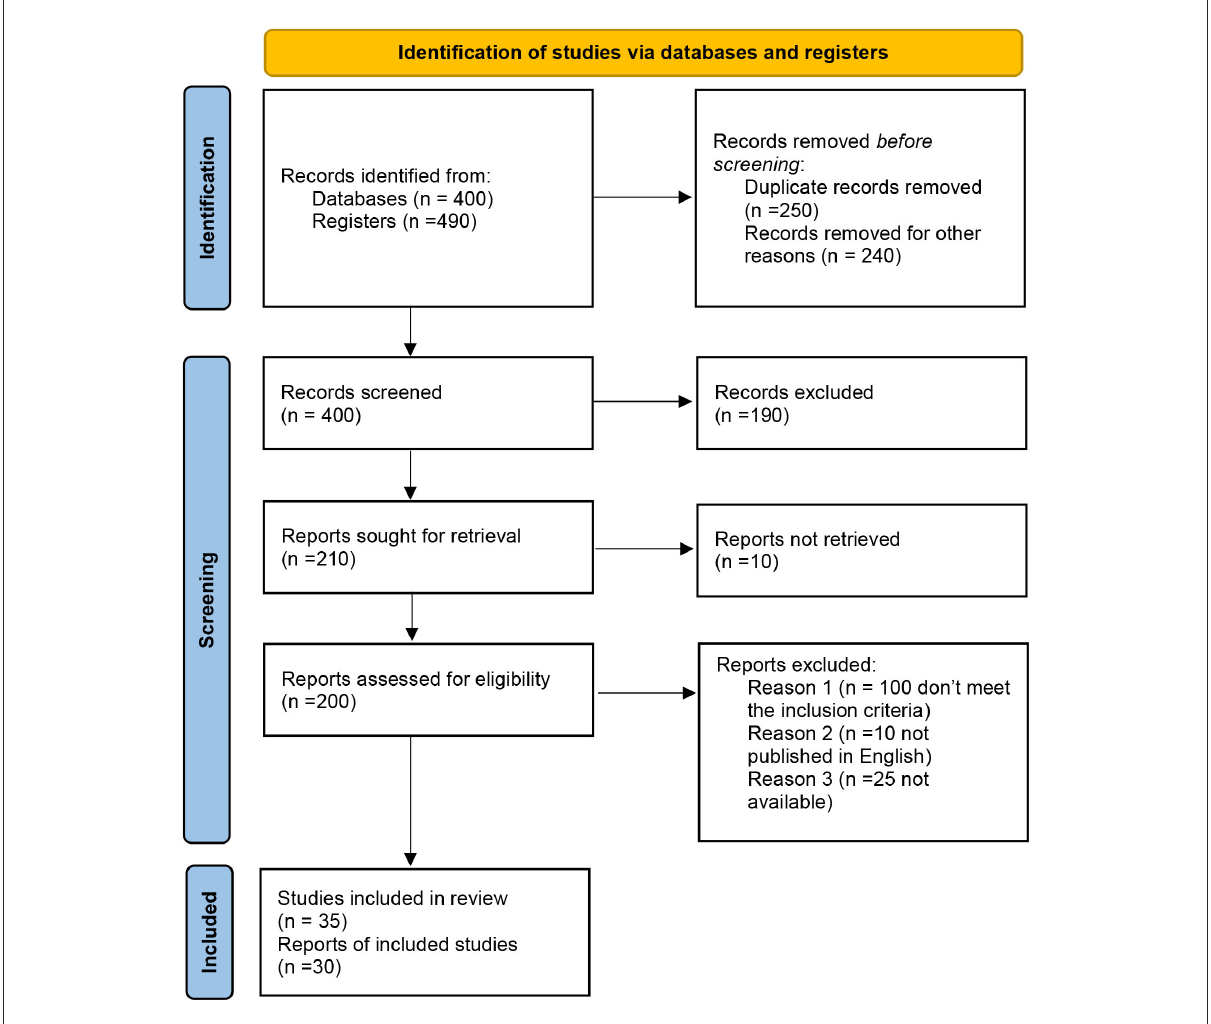
FIGURE1 Identification of studies.